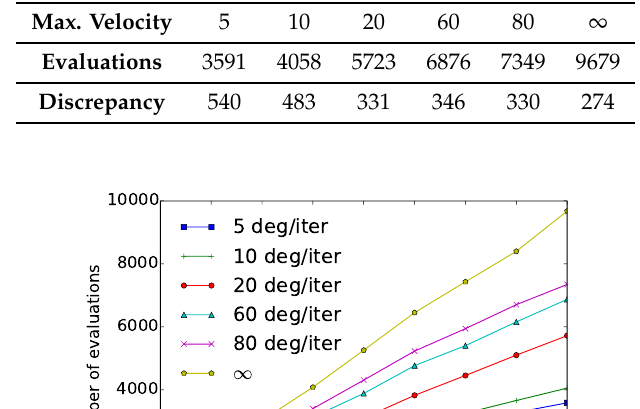
Table 4. “Wax” velocity constraint experiment results.